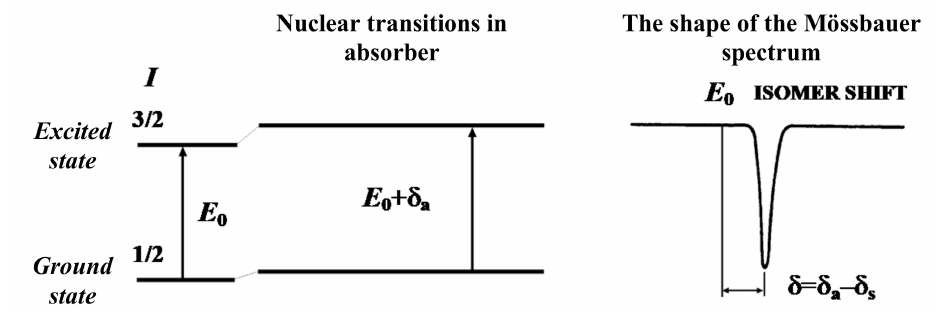
Figure A4. Scheme of the nuclear electric monopole interaction and isomer shift δ for the 57 Fe, resonance transition and resulting shape of the Mössbauer spectrum. I is a nuclear spin.